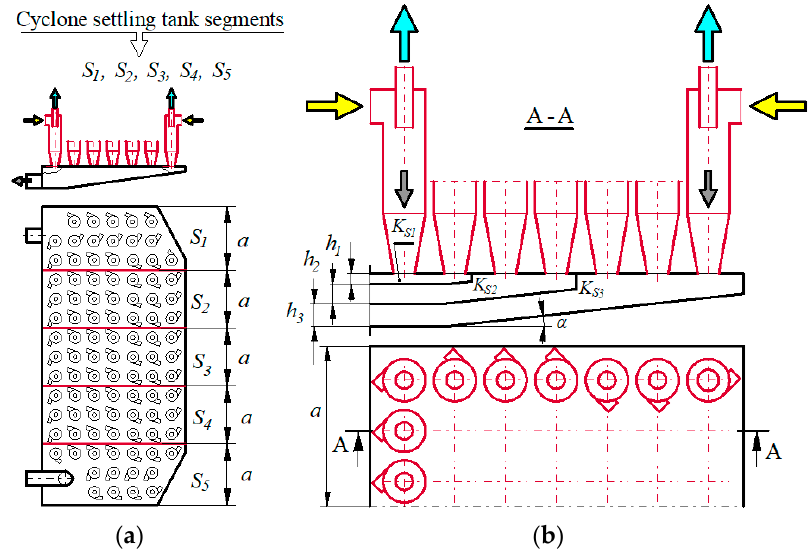
Figure 11. Dust suction concept from MT multi-cyclone: ( a ) schematic division diagram of multi- cyclone dust settler into segments, ( b ) chamber dividing principle of segment dust settling chamber into suction channels.